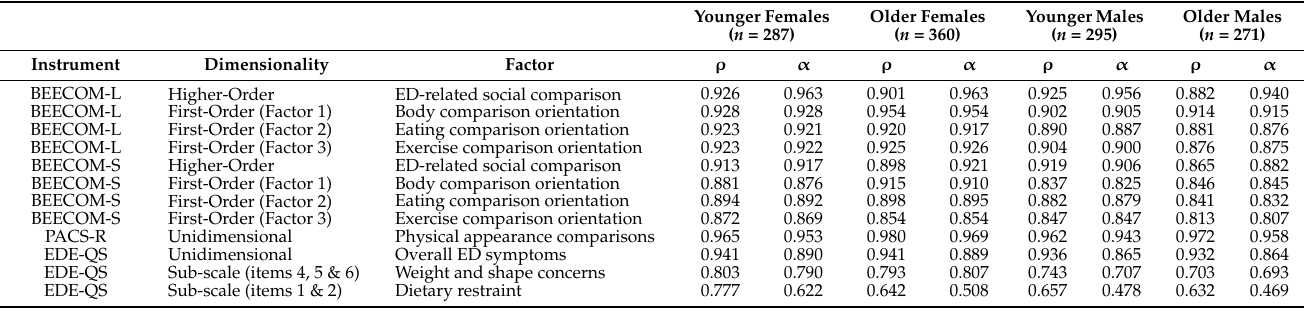
Table 1. Composite reliability ( ρ ) and internal consistency ( α ) of study measures across population subgroups.